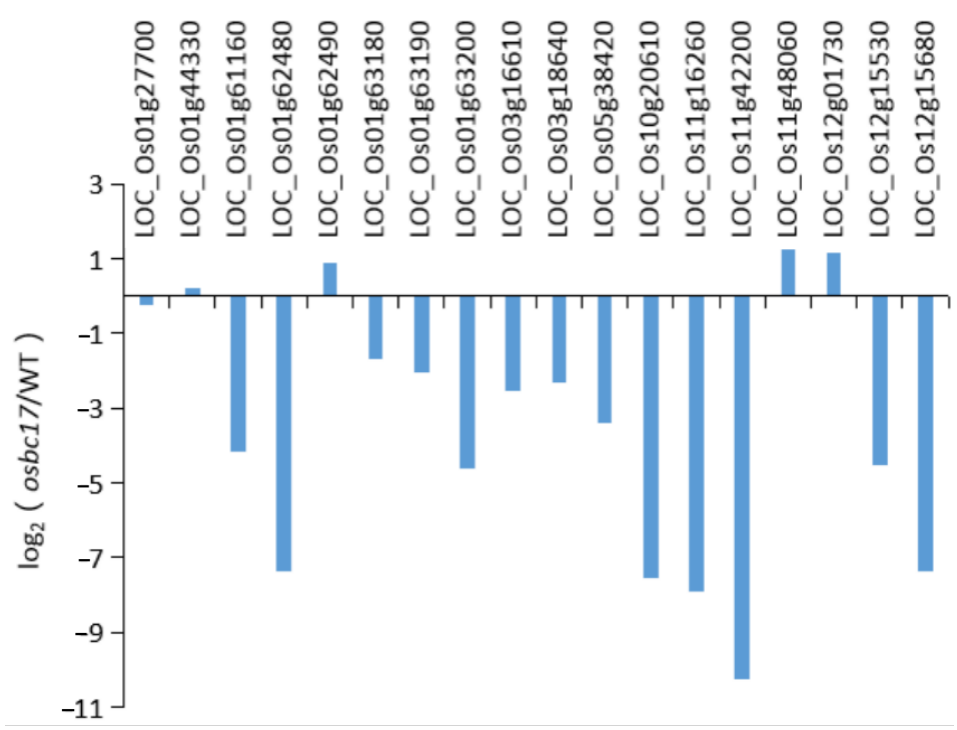
Figure 8. Relative expression difference in putative laccase precursors in wild type and mutant osbc17. Transverse axis: putative laccase precursor gene locus; longitudinal axis: relative gene ex- pression.